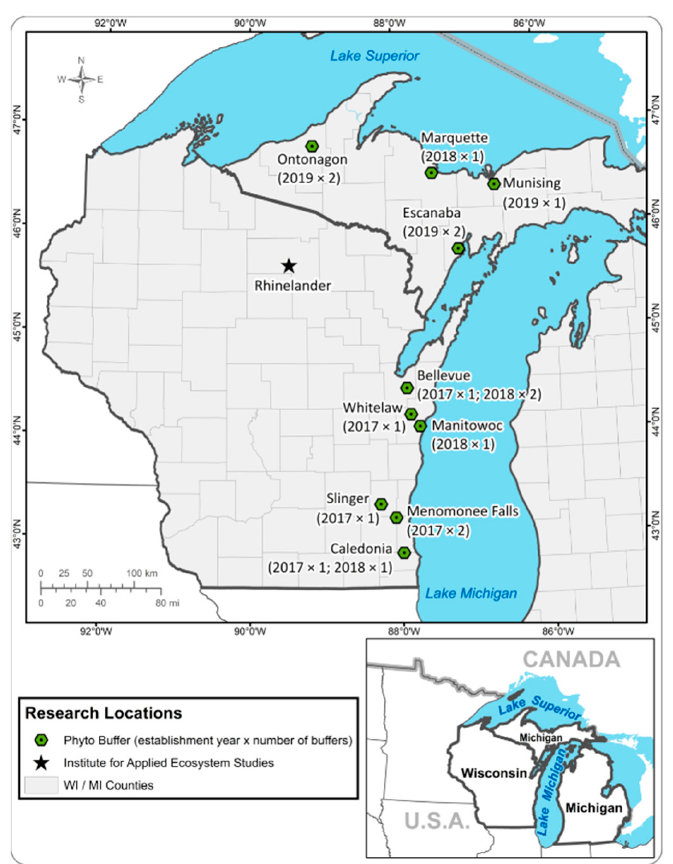
Figure 1. Regional phytotechnologies network consisting of sixteen phytoremediation buffer systems (i.e., phyto buffers) established in 2017 (×6 phyto buffers), 2018 (×5), and 2019 (×5) in the Lake Superior watershed of the Upper Peninsula of Michigan, USA and the Lake Michigan watershed of eastern Wisconsin, USA.